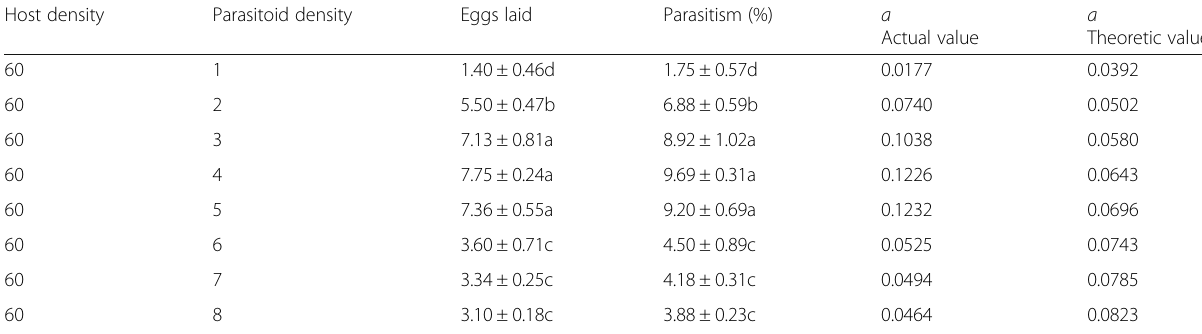
Table 6 Parasitic function of the different density Er. sp. nr. furuhashii on Bemisia tabaci nymph (M ± SE) Host